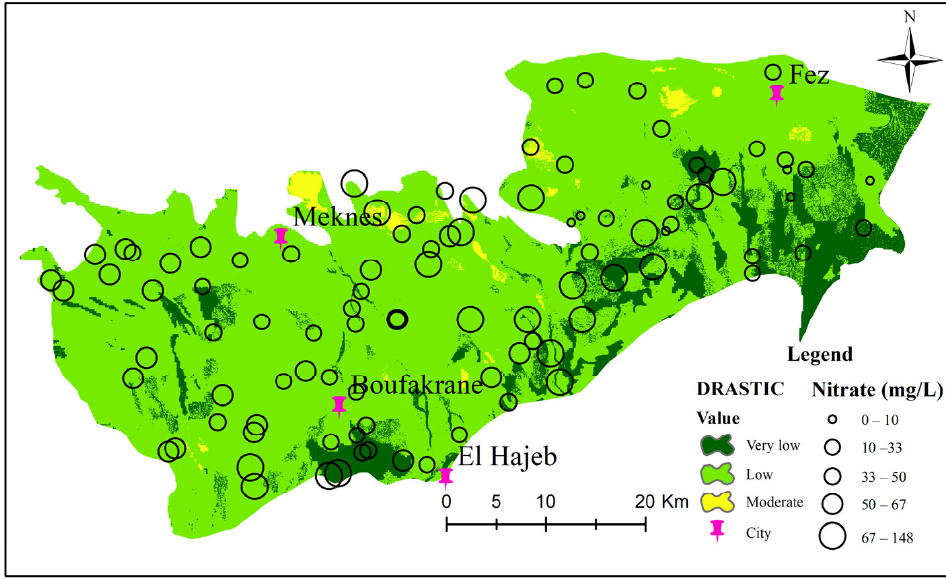
Figure 5. Vulnerability map using original DRASTIC method.